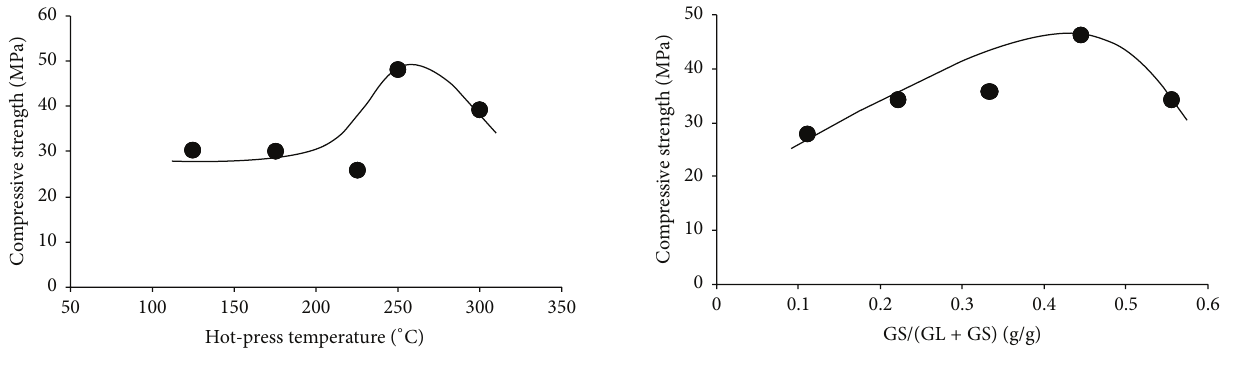
Figure 4: Effect of the hot-press temperature on the composite compressive strength. Synthesis parameters used were as follows: 6 g GL, 3g GS, 1.5g paper, 1.5g plastic, 1g cloth, 3g PVAc, and 13 mL water.